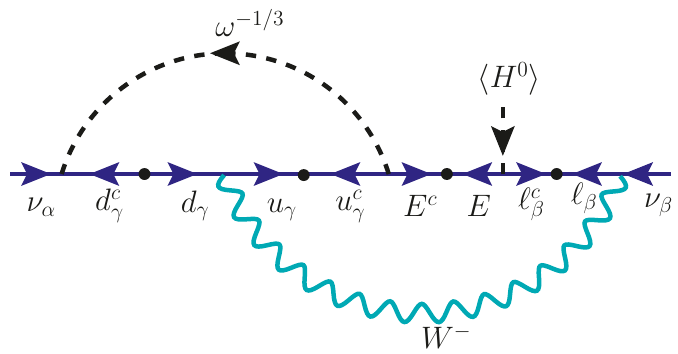
Figure 49 . Two-loop neutrino mass generation with SU(2) L -doublet LQ and vector-like lepton, 2 corresponding to of table 5 8 O